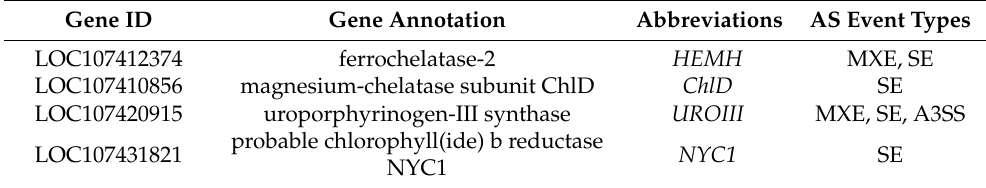
Table 7. Annotation information of chlorophyll-related genes in differentially alternative splice genes specific to ALA + NaCl treatment of wild